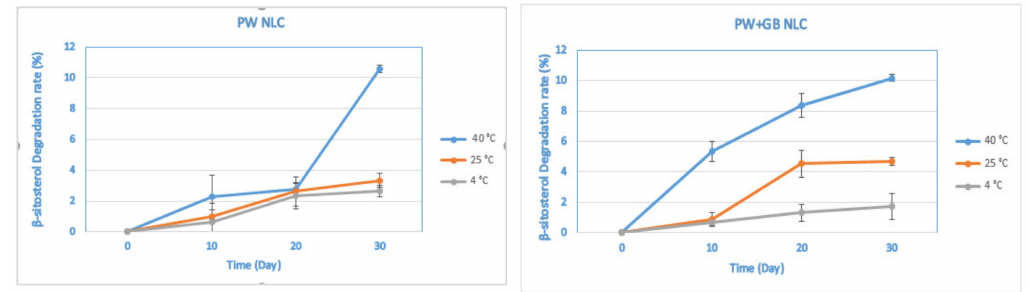
Figure 2. E ff ects of storage on the chemical stability of β -sitosterol NLC dispersions at di ff erent temperatures (4, 25 and 40 ◦ C) over time. PW and PW + GB represent the NLCs formulated with propolis wax alone or its binary mixture with glyceryl behenate (1:1),